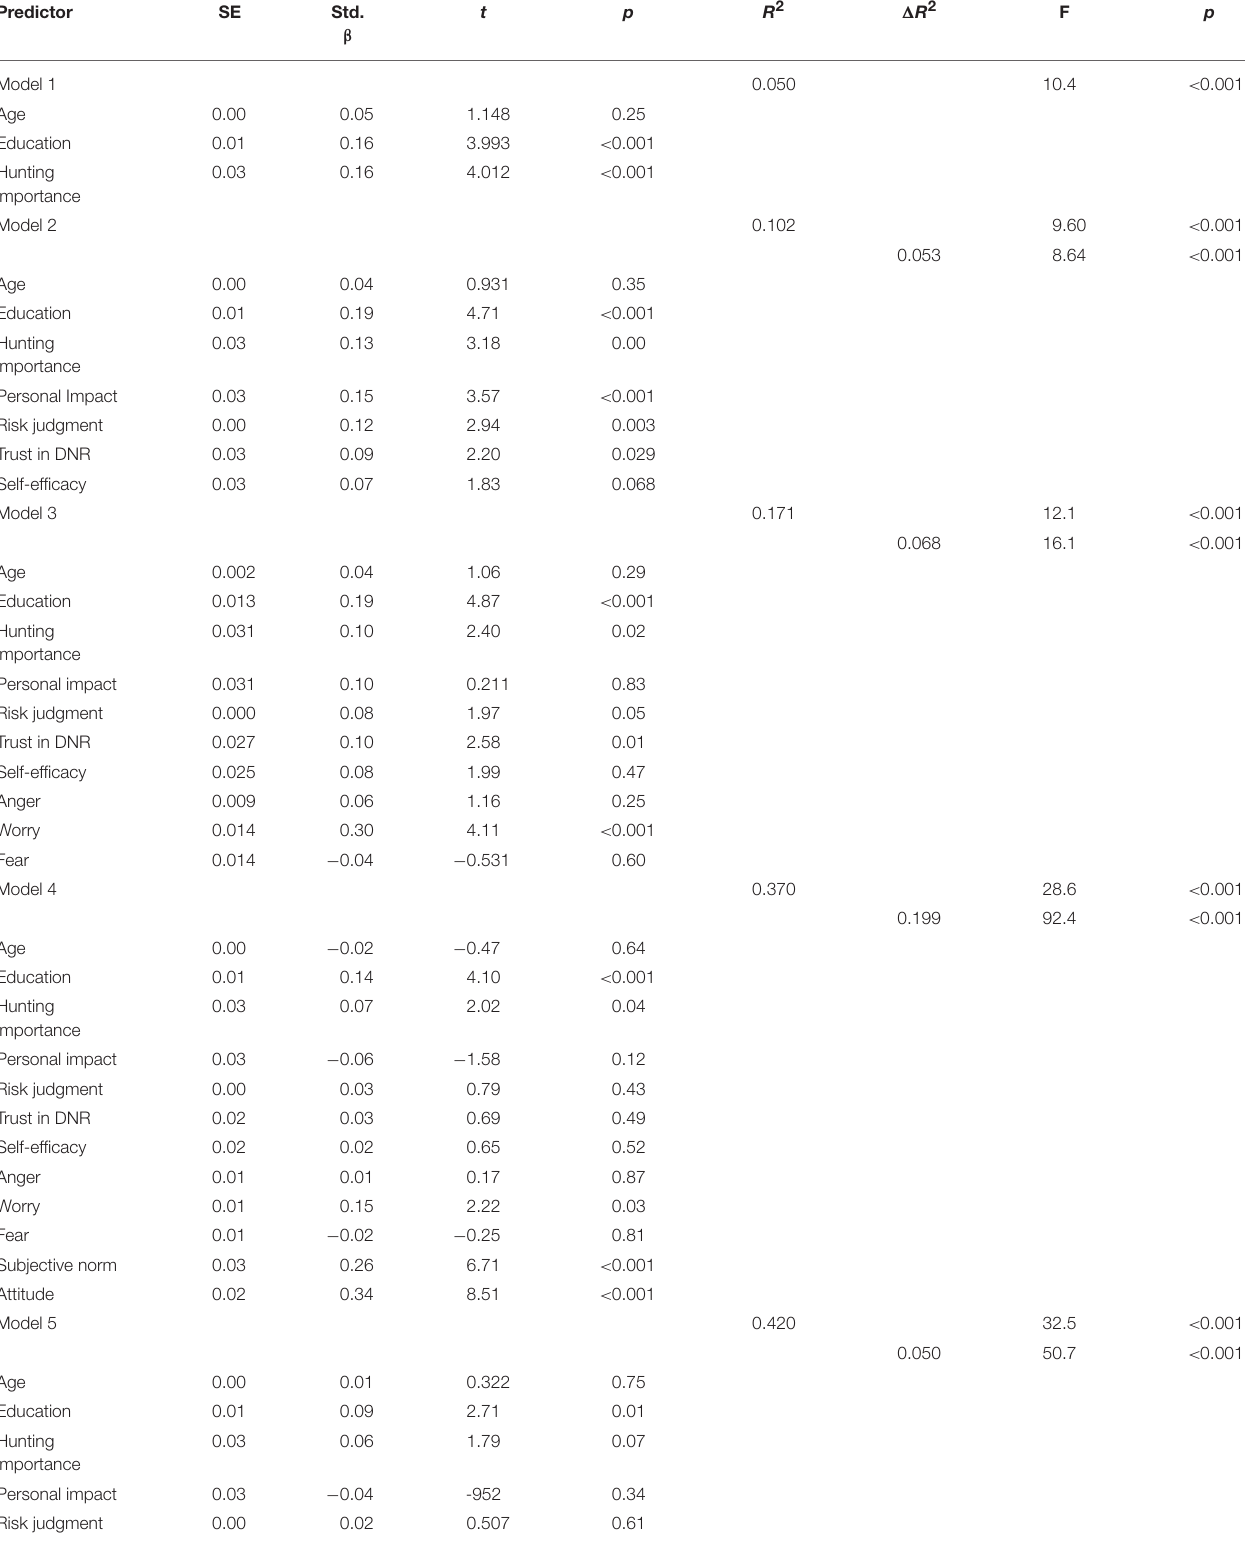
TABLE 3 | RISP framework hierarchical regression models of self-reported information seeking behaviors in northwest Minnesota hunters, data from 2012. Predictor SE Std.